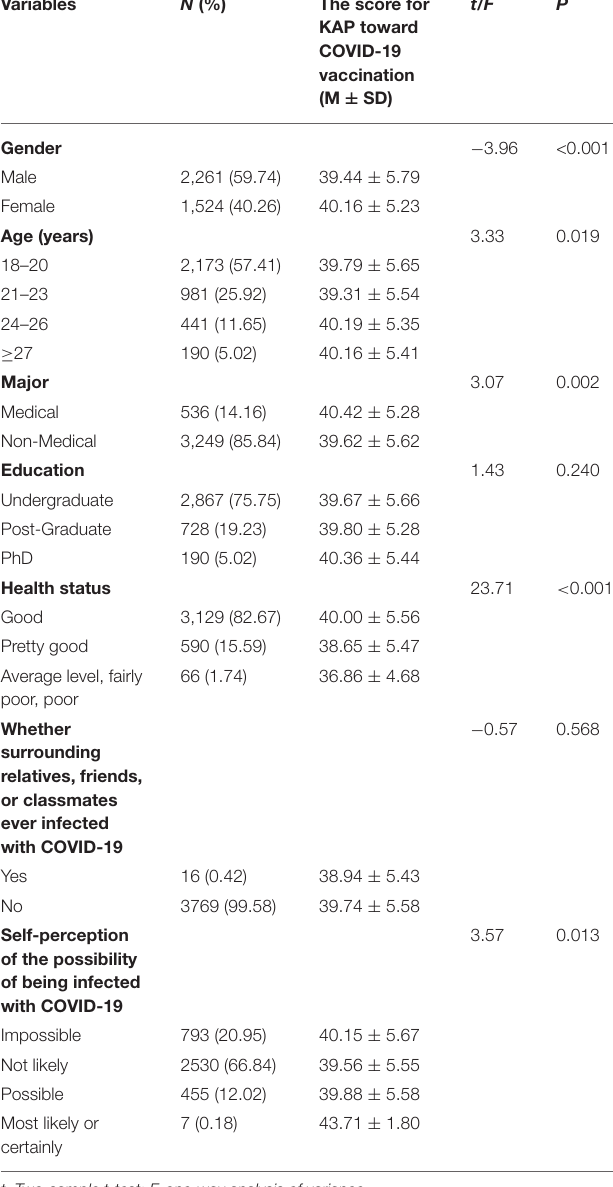
TABLE 1 | Socio-demographic characteristics and univariate analysis for KAP toward COVID-19 vaccination. Variables N (%) The score for KAP